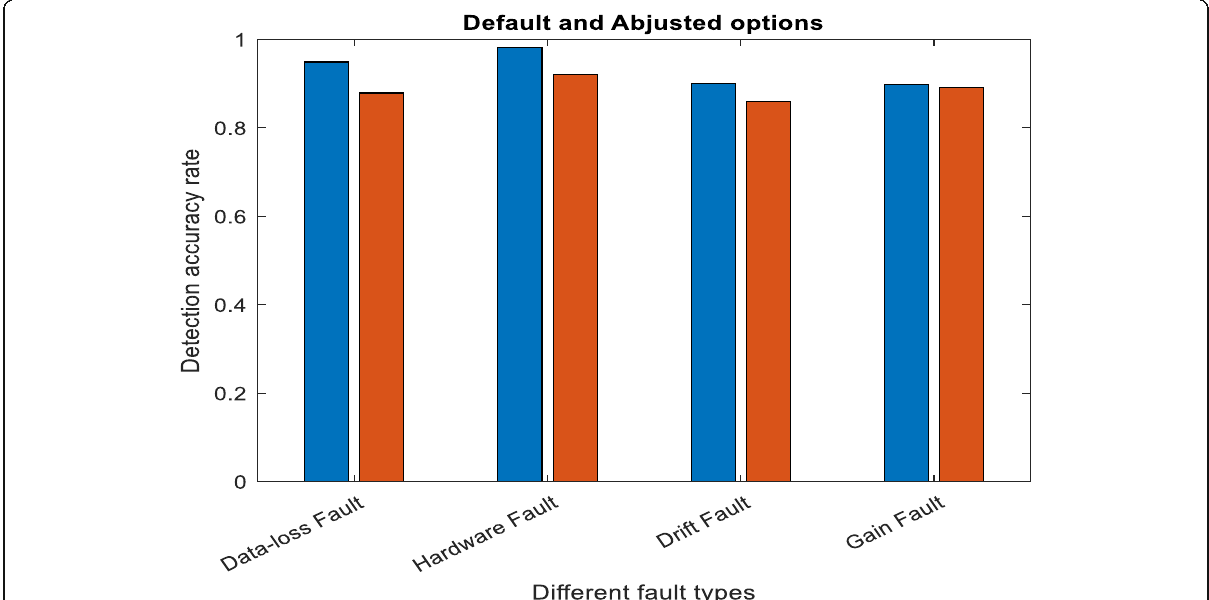
Fig. 13 Comparison between the adjusted and default options of the proposed scheme for the testing set with different faulty, e.g., data loss, hardware, drift, and gain faults according to the DA